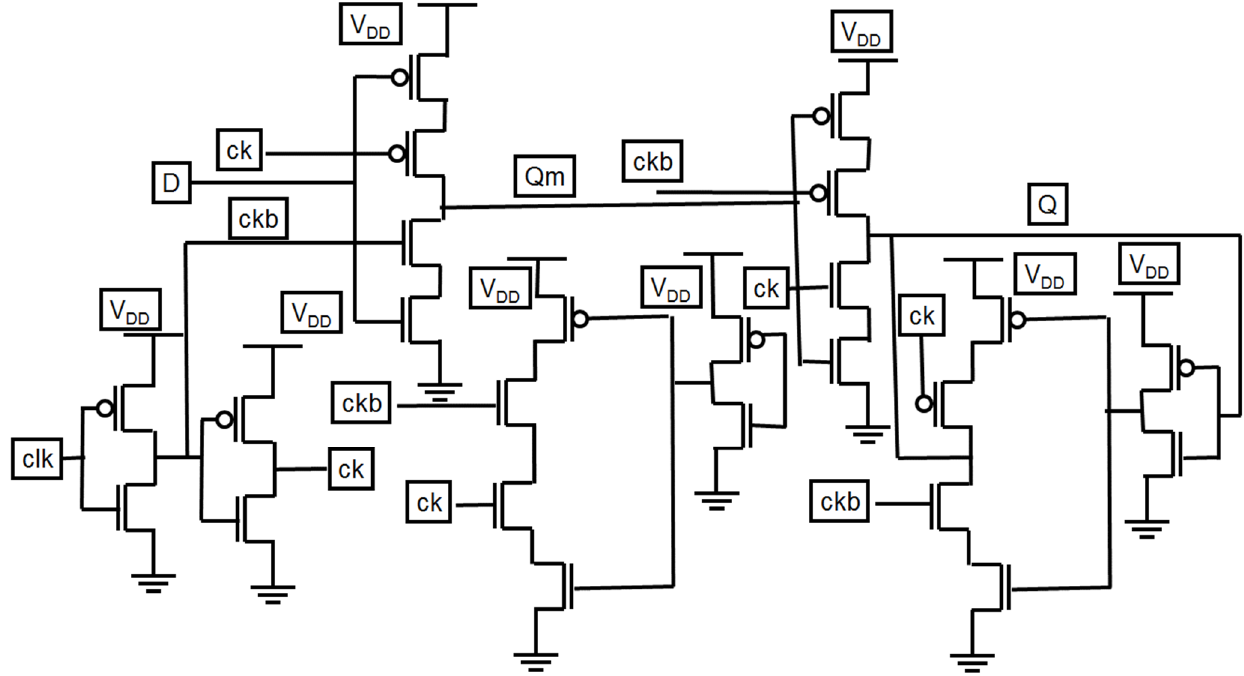
Figure 8. Schematic of the modified C²MOS latch.